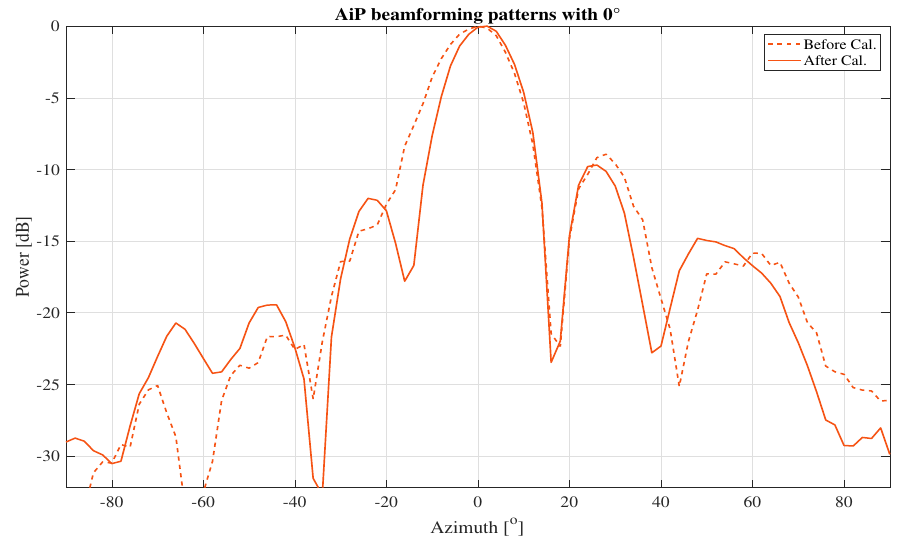
Figure 7. AiP beamforming patterns at 0° without and with calibration.